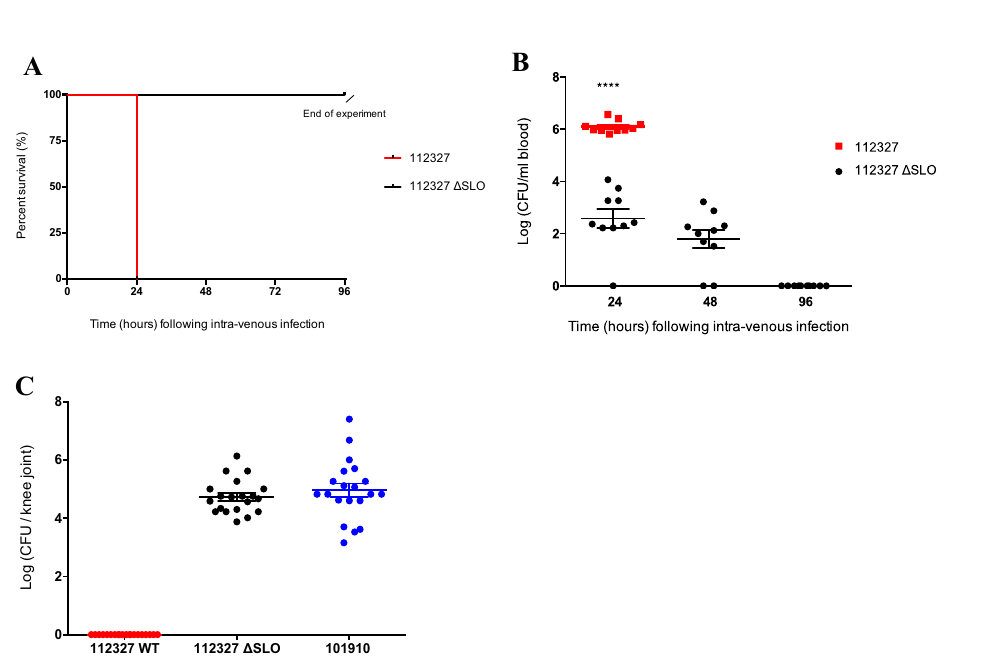
Figure 6. SLO deficiency increases in vivo survival and switches phenotype. ( A ) Kaplan Meier plots representing percentage survival of CD1 mice (n = 10 per group) following 10 8 CFU intravenous infection with isolates emm type 32.2 (isolate 112,327) and emm type 32.2 (isolate ΔSLO 112,327). ( B ) The bacterial CFU in blood for each isolate over time. ( C ) Bacterial load in knee joints (n = 20) at 24 h. ****p value < 0.0001 when analysed using a two tailed Mann–Whitney U